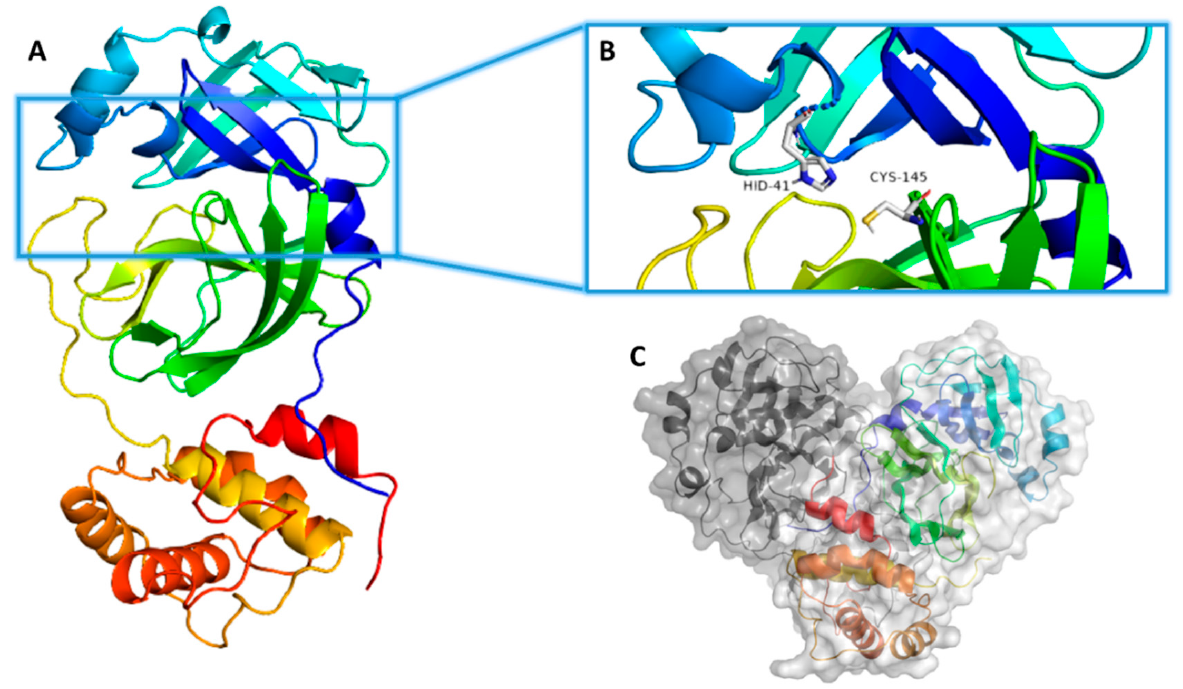
Figure 1. ( A ) Monomeric structure of SARS CoV-2 M Pro (PDB: 6LU7) showing its three main domains (I, II, and III; blue, green, and orange, respectively). ( B ) M Pro active site showing the catalytic dyad (HIS41–CYS145). ( C ) The dimeric active form of SARS CoV-2 M Pro .